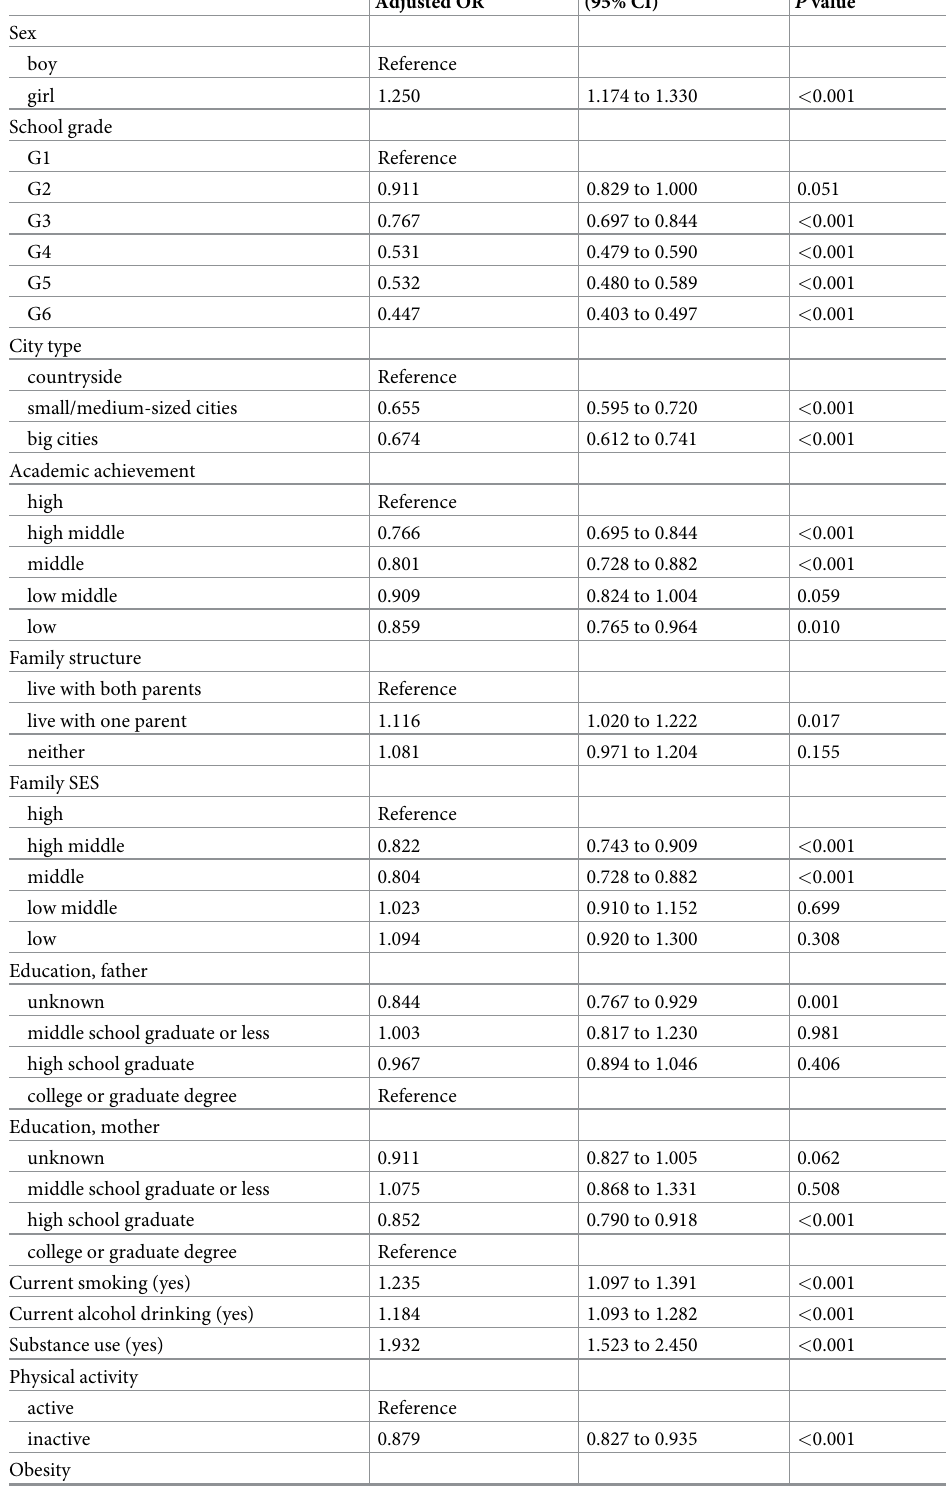
Table 3. Multivariate logistic regression analysis to identify factors associated with high risk of